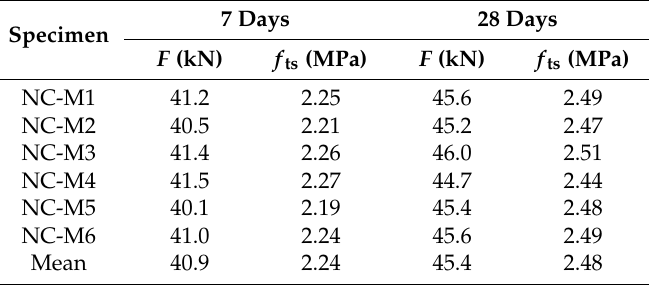
Table 4. Splitting test results of test specimen series NC-M (normal concrete with magnetic orientation).